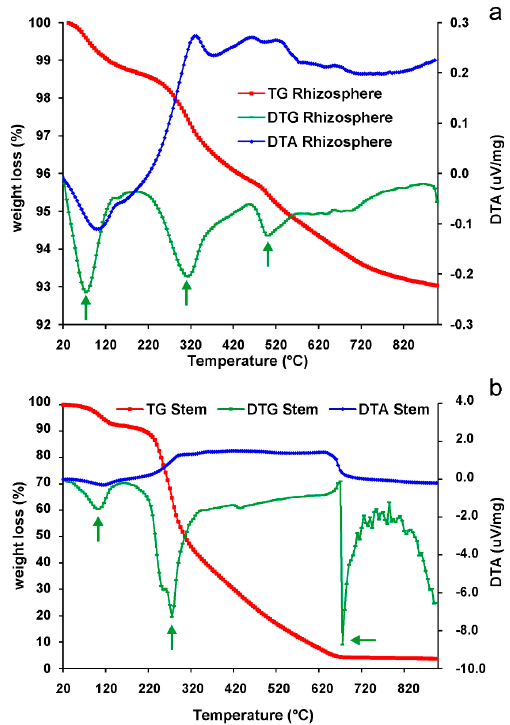
Figure 3. Results of thermal analyses on the rhizosphere ( a ) and the stem ( b ) from Rio Irvi samples. Green arrows indicate the main negative peaks in the derivative of the thermogravimetry (DTG) curves.